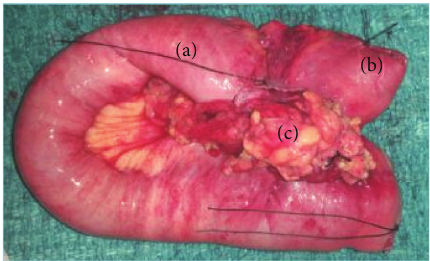
Figure 2: The resected specimen showing the affected jejunal segment (a) and adherent mesentery (c) with resected segment of transverse colon